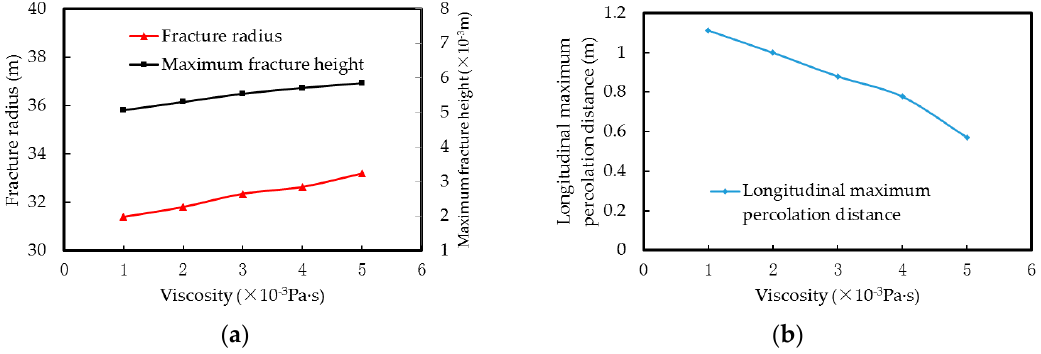
Figure 12. Influence of viscosity on fracture morphology and longitudinal maximum percolation distance: ( a ) Influence of viscosity on morphology and ( b ) influence of viscosity on longitudinal maximum percolation distance.